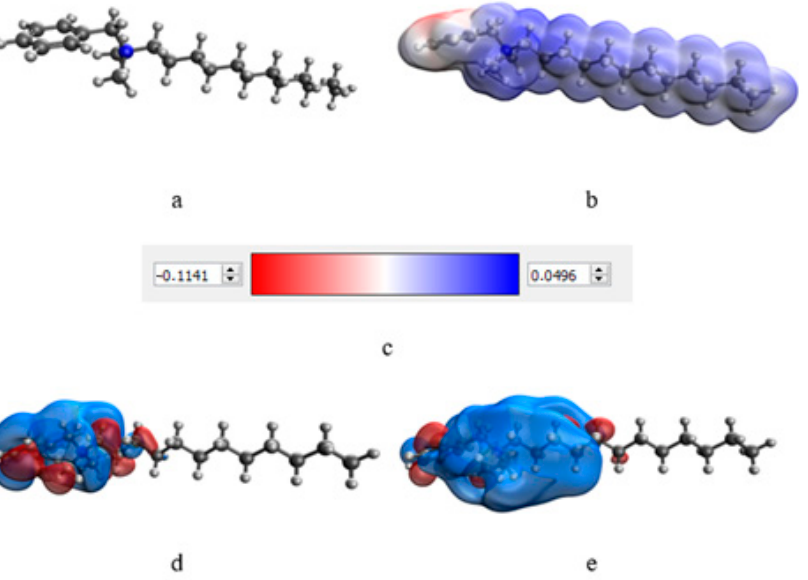
Figure 3. Results of modeling of the catamine AB molecule: molecular complex model ( a ), electron density distribution ( b ), electron density distribution gradient ( c ), highest populated molecular orbital HOMO ( d ), and lowest free molecular orbital LUMO ( e ).